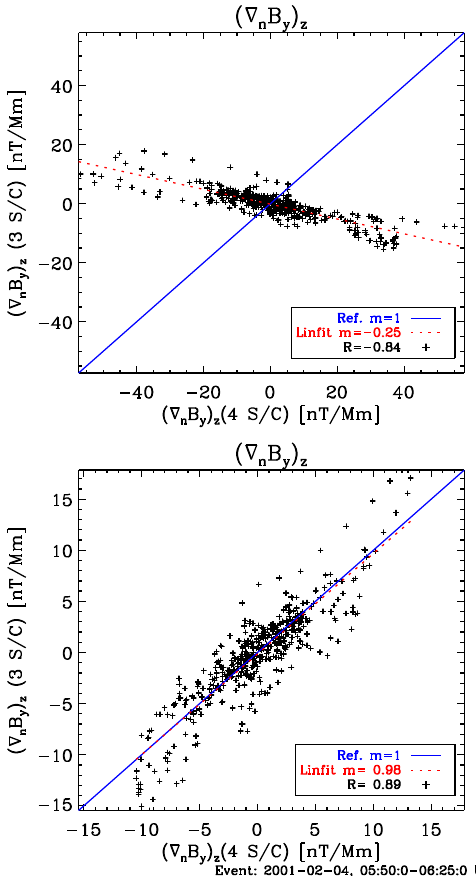
Fig. 3. 4 February 2001, 05:50–06:25UT: Three-point normal derivative estimates ∇ n B y using the geometric constraint ∇ B y k ˆ e versus the corresponding four-point estimates. The unit vector ˆ e is chosen to be the normalized ambient magnetic field direction ˆ B (up- per panel) and the minimum variance direction ˆ x min (lower panel). Notation as in Fig.